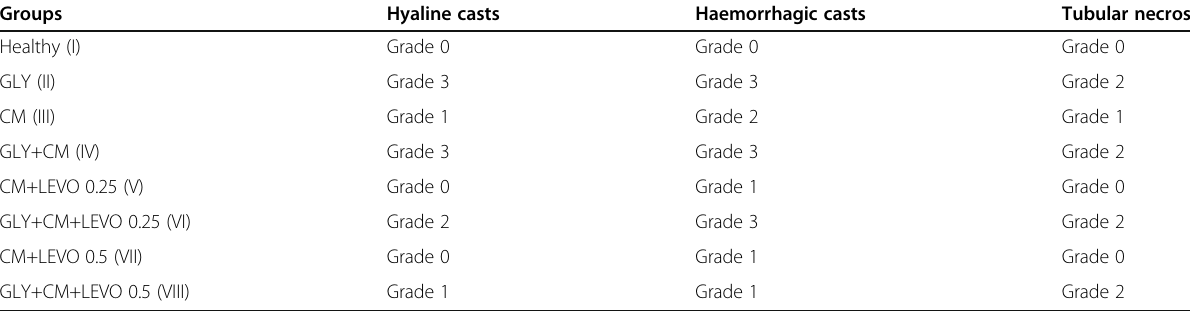
Table 4 Histopathological scores according to experimental groups Groups Hyaline casts Haemorrhagic